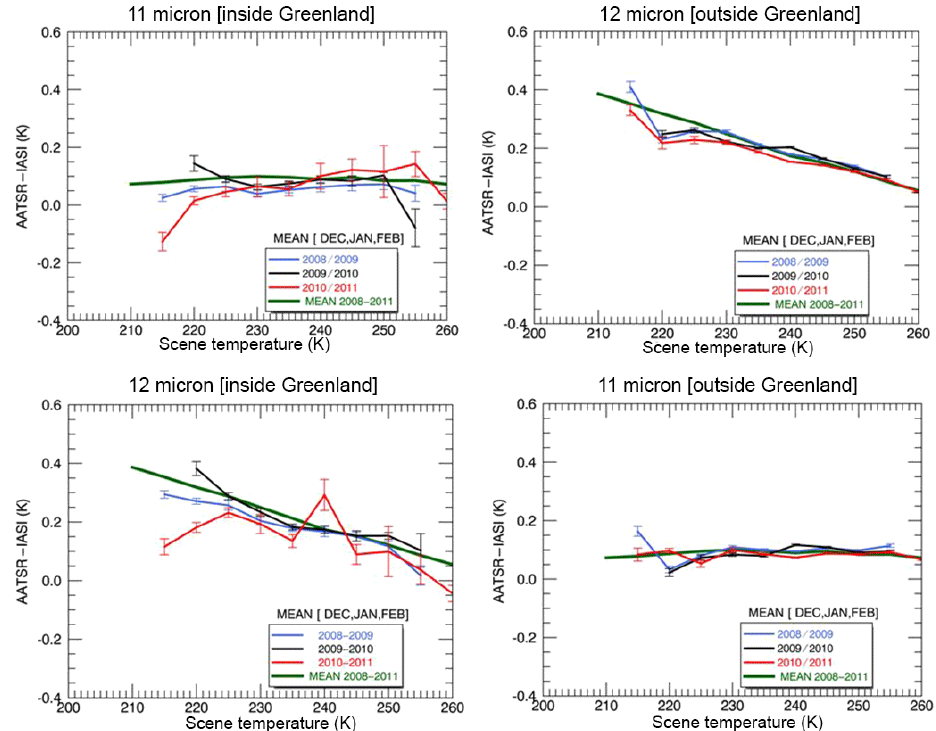
Figure 8. Comparison of AASR–IASI-A bias over Greenland and outside Greenland. The anomalous trend seen in November 2010 DFJ AATSR–IASI bias is mainly confined to